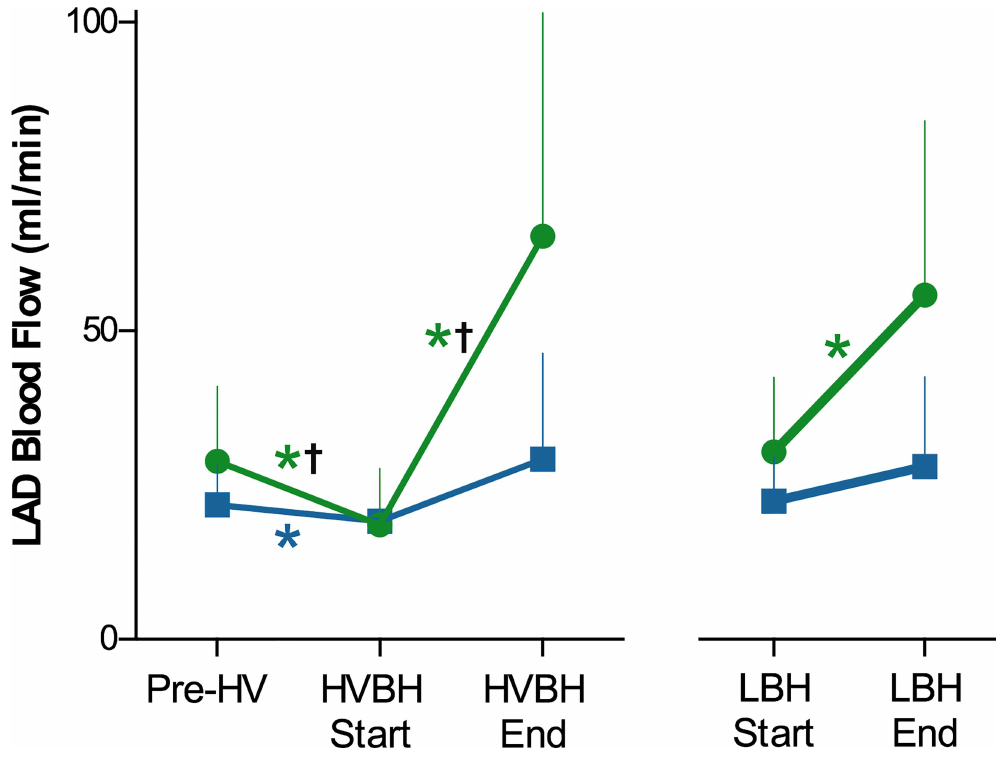
Fig 3. Changes of coronary blood flow during breathing maneuvers. Mean changes of coronary blood flow (ml/min) inducedby breathing maneuvers in control (green) and stenosis (blue) animals. All maneuvers significantly changedthe flow ( * p < 0.05) for control animals, while only hyperventilation altered the coronary blood flow for the stenosis group, (%-change is listed in S1 Table). Both hyperventilation (HV) and the hyperventilation breath-hold (HVBH) triggered a flow response that was significantly different between stenosis and control animals († p < 0.05), while there was no statistically significant difference between the groups observed with the long breath- hold